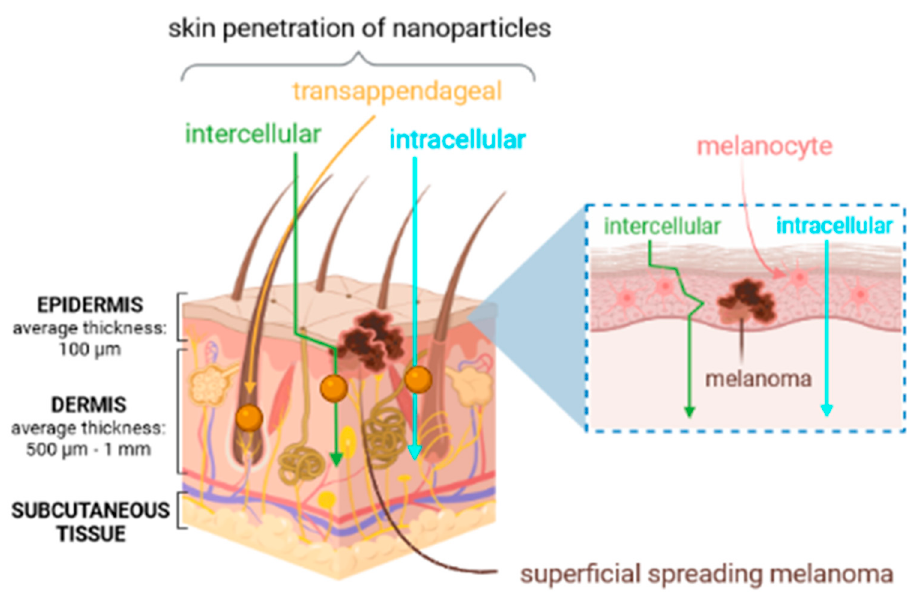
Figure 2. Different pathways of skin penetration of nanoparticles and superficial spreading mela- noma (own